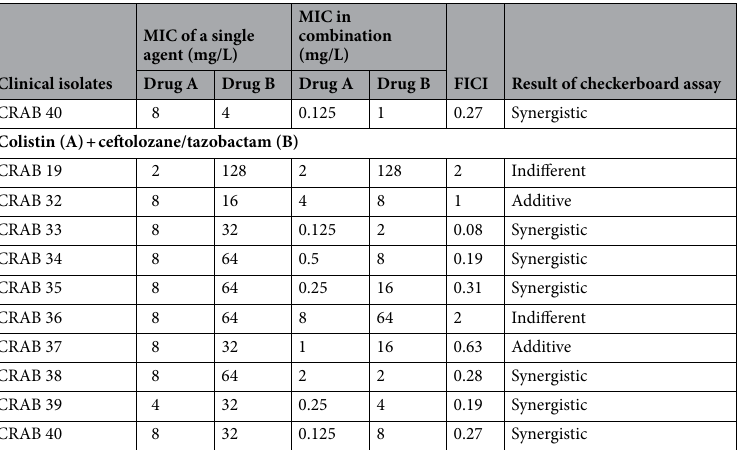
Table 3. Results of checkerboard assay for two-drug combinations against clinical isolates of Acinetobacter baumannii. CRAB carbapenem-resistant Acinetobacter baumannii , FICI fractional inhibitory concentration index, MIC minimum inhibitory concentration.